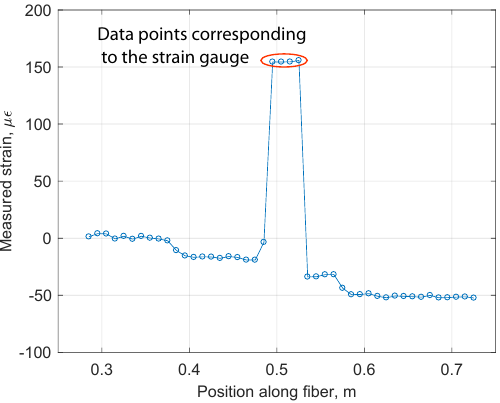
Figure 12. Sample of the measured data, plate of 1 mm thickness.